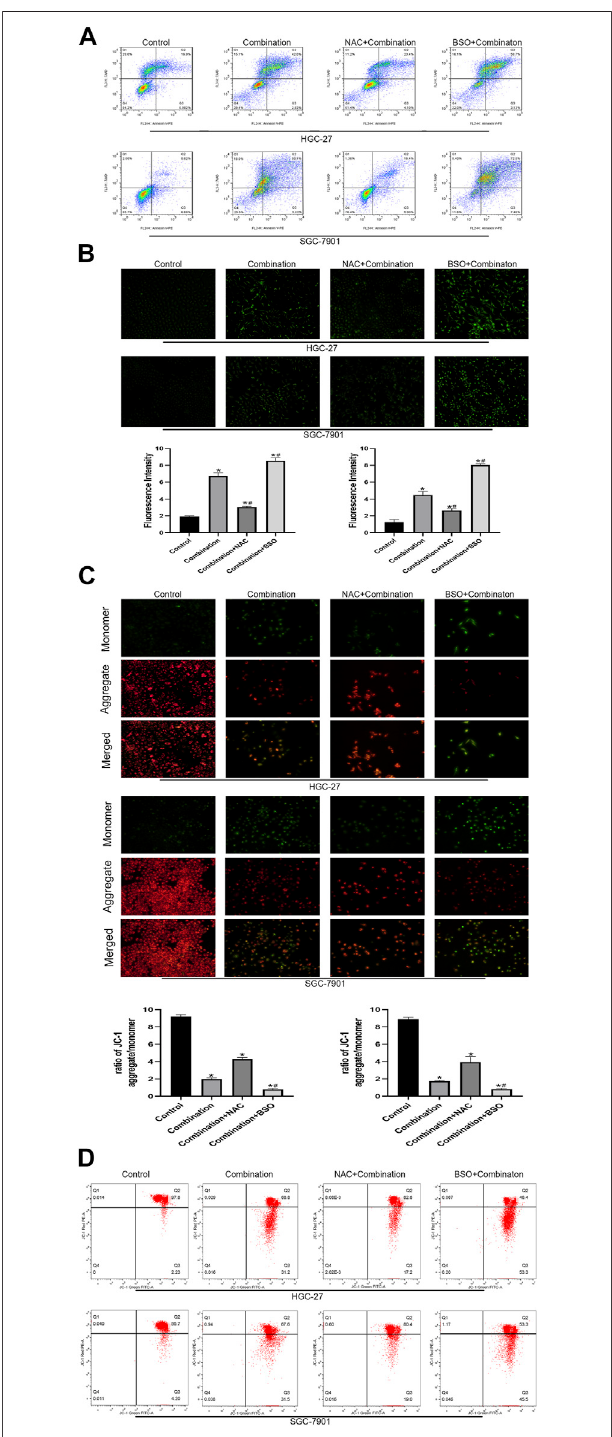
FIGURE6| Pretreatment withNAC and BSOrespectivelyin fl uences the apoptosis of GC cells induced by soduim butyrate and cisplatin. (A) Quantitative fl ow cytometry measurements of apoptosis in HGC-27 cells (control, 4 µg/ml cisplatin +10 mM sodium butyrate, NAC pretreated + combination, or BSOpretreated +combination) and SGC-7901 cells (control, 4 µg/ml cisplatin +5 mM sodium butyrate, NAC pretreated + combination, or